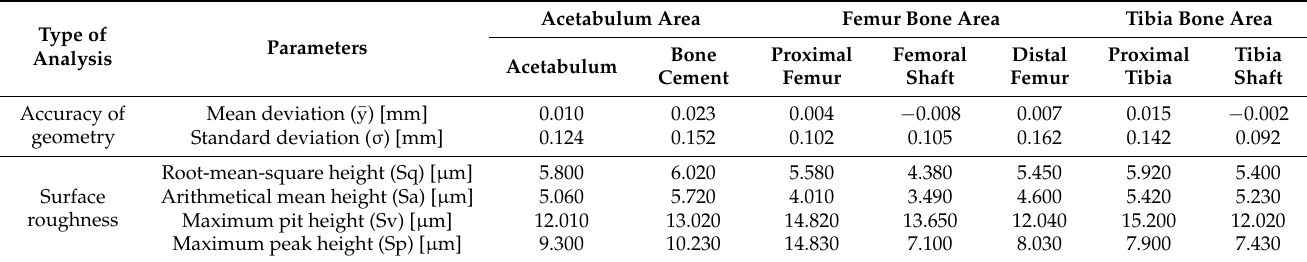
Table 11. Statistical parameters—using a